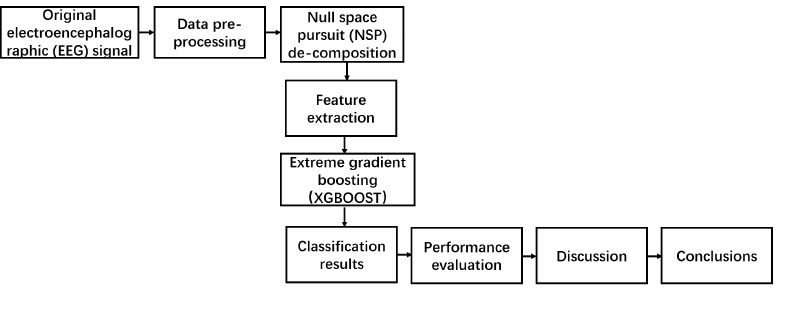
Figure 1. Workflow diagram for model building in this work.